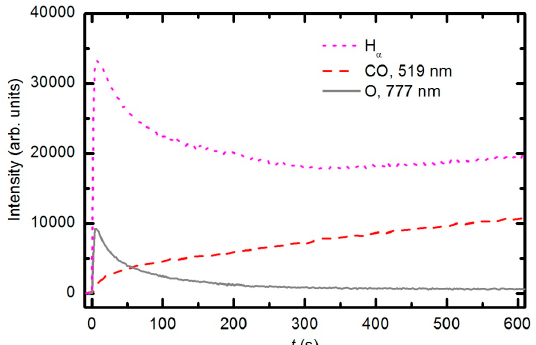
Figure 8. Time evolution of the CO emission peak (519.5 nm), O (777.4 nm) line and Balmer H α line during sample etching with oxygen plasma generated at a pressure of 33 Pa and 150 W forward RF power.